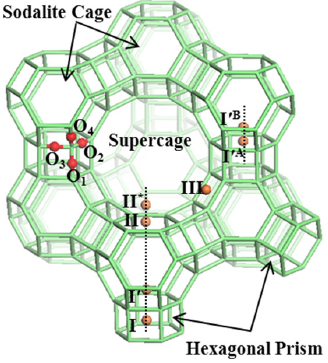
Figure 1. Faujasite type structure with cationic sites (orange balls) and different crystallographic oxygen positions (red balls). Here, site I is at the middle of hexagonal prism; site I’B is in the sodalite cage adjacent to 6MR which is shared by both hexagonal prism and sodalite cage; site I’A is similar to site I’B, but away from the sodalite cage; site II is in the supercage close to the six-membered ring (6 MR) shared by supercage and sodalite cage; site II* is similar to site II, but located towards the supercage; site III is in the supercage that is next to four-membered rings (4 MR) of sodalite cage. According to the literatures [30,41,42], the local conformation and interactions of by H atoms [41,43]. The terminal H atoms were oriented along the bond direction of Y zeolite. The bond length of O-H was set to 1.0 Å, respectively. During numerical optimization, the local structure of Y zeolite was kept unchanged for Y n − , Y, CuY cluster models. The compensating charges, Al atoms and adjacent SiO 4 units were relaxed, while other atoms were fixed. For the adsorbate-CuY cluster system, the compensating charges, the absorbed molecules and the 6 MR occupied by the active center Cu + species were relaxed. In order to find the appropriate cluster size, five different sized clusters, consisting of 6T, 12T, 24T, 42T, and 60T atoms (T represents an Al or Si atom) (see Error! Reference source not found. ), were constructed. Figure 2. The cluster geometries of Y zeolite with different sizes. Red, yellow, pink and white balls stand for O, Si, Al and H atoms, respectively. The binding energies of Cu 2+ in these five Y clusters and the adsorption energies of CO on CuY zeolite with these clusters were calculated, as shown in Table 1. Table 1. The interaction energies ( E int ) of Cu 2+ and the adsorption energies ( E ads ) of CO on the clusters of Cu 2+ Y zeolites with different sizes. Y Zeolite with Different Size